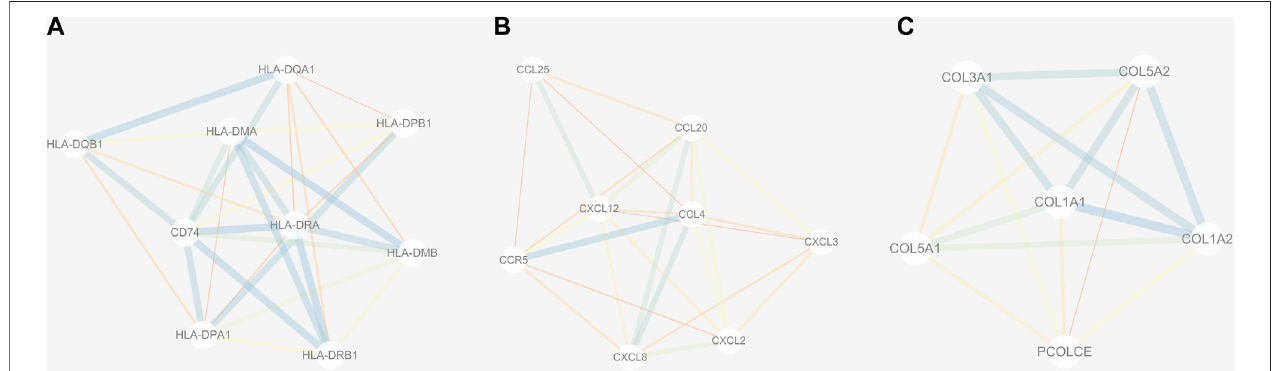
FIGURE 6 | Three submodules (A – C) of the PPI network. Line with small sizes or bright colors: low combined